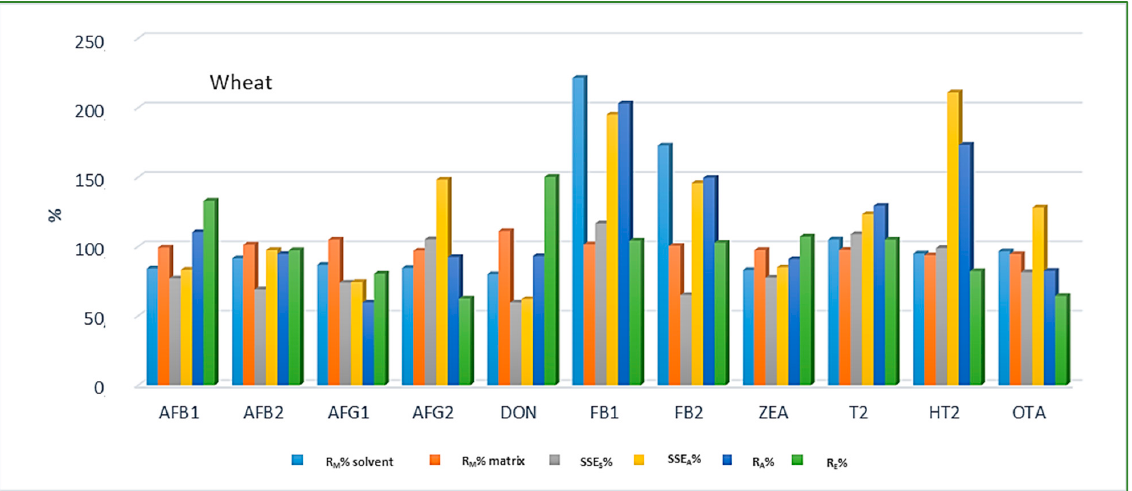
Figure 4. Method recovery (R M ), matrix effect (SSE S -slope, SSE A -area), apparent recovery (R A ) and extraction efficiency (R E ) in wheat.